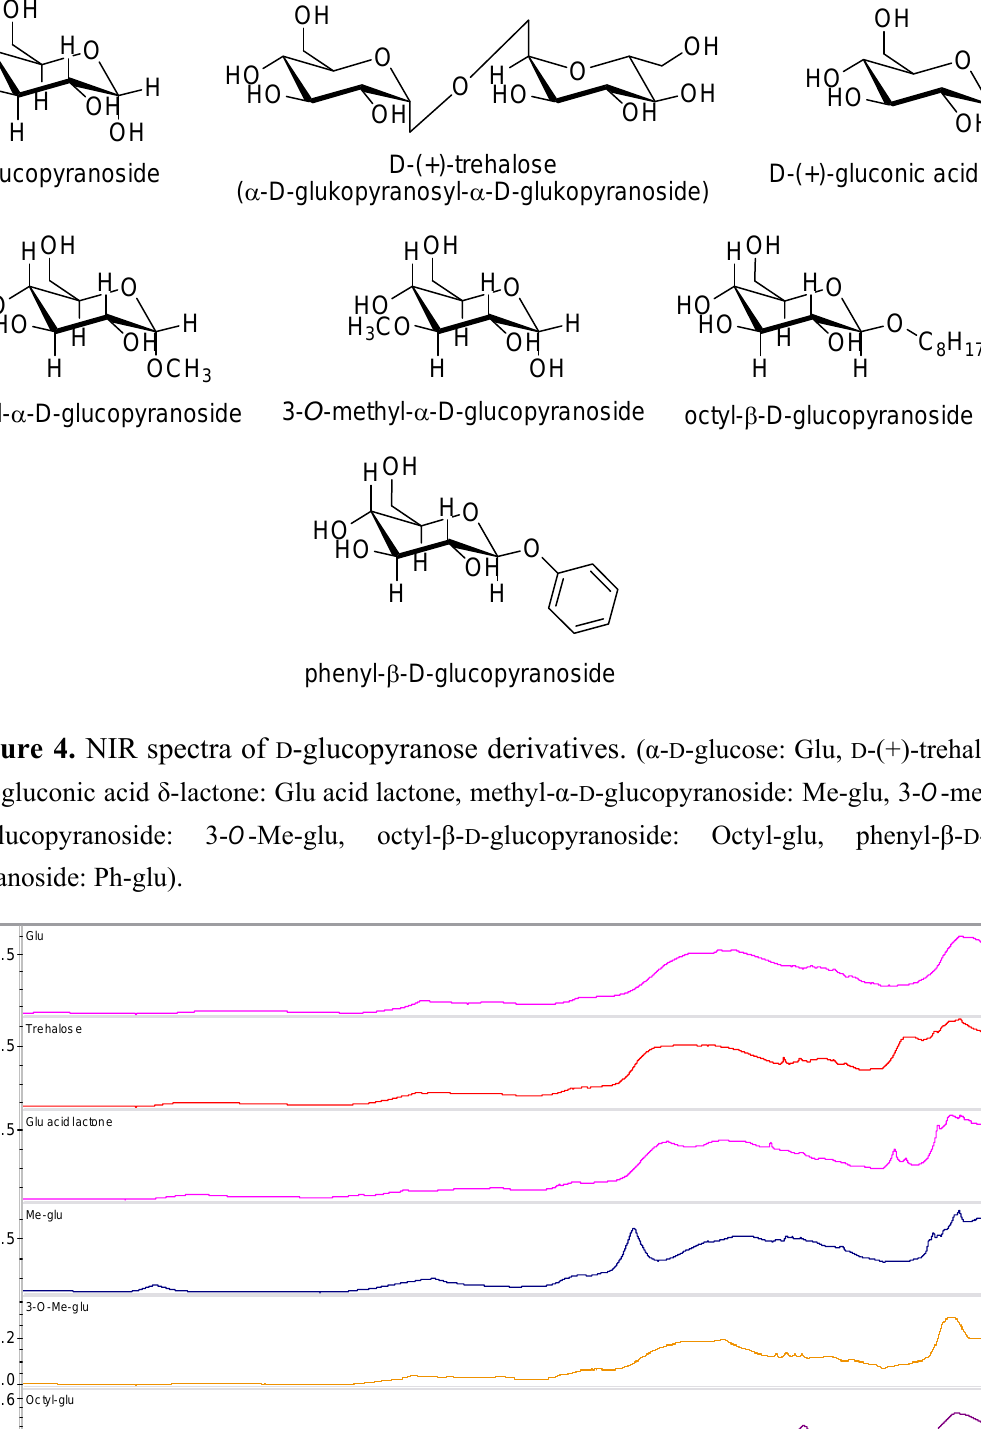
Figure 3. Structure of starting derivatives of glucose used as potential counterions.